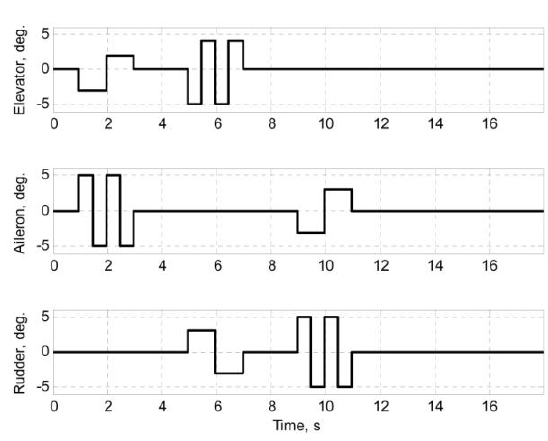
Figure 5. Orthogonal square-wave